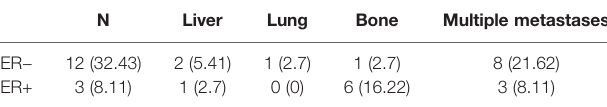
Data are presented as n (%). ER − , the proportion of ER ≤ 25%; ER+, the proportion of ER>25%; N, patients with clavicle area and/or inner mammary area lymph node metastases. p= 0.037 (chi-square inner mammary area lymph node metastases ( fi ve [13.51%] patients